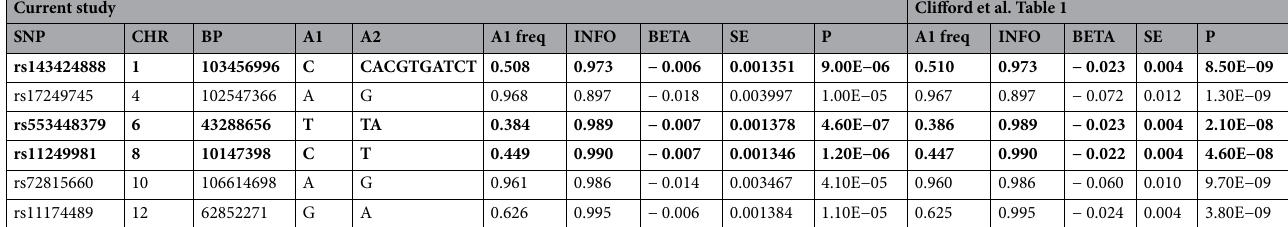
Table 4. A comparison of the summary statistics for six SNPs in the current study that were reported as genome wide significant in the study by Clifford et al. Bold denotes those SNPs that were replicated in the Clifford et al. study. Chr, chromosome; SNP, single nucleotide polymorphism; bp, base position; A1, allele A1; A2 allele A2; A1 freq, allele frequency of allele A1; Info, estimated imputation info score; beta, effect size from BOLT-LMM approximation to infinitesimal mixed model; se, standard error of the beta; p-value, non- infinitesimal mixed model association test p-value. NB. In Table 1 of Clifford et al. in the printed paper the effect sign is opposite for rs143424888, which appears to be an error; see their Supplementary eTable